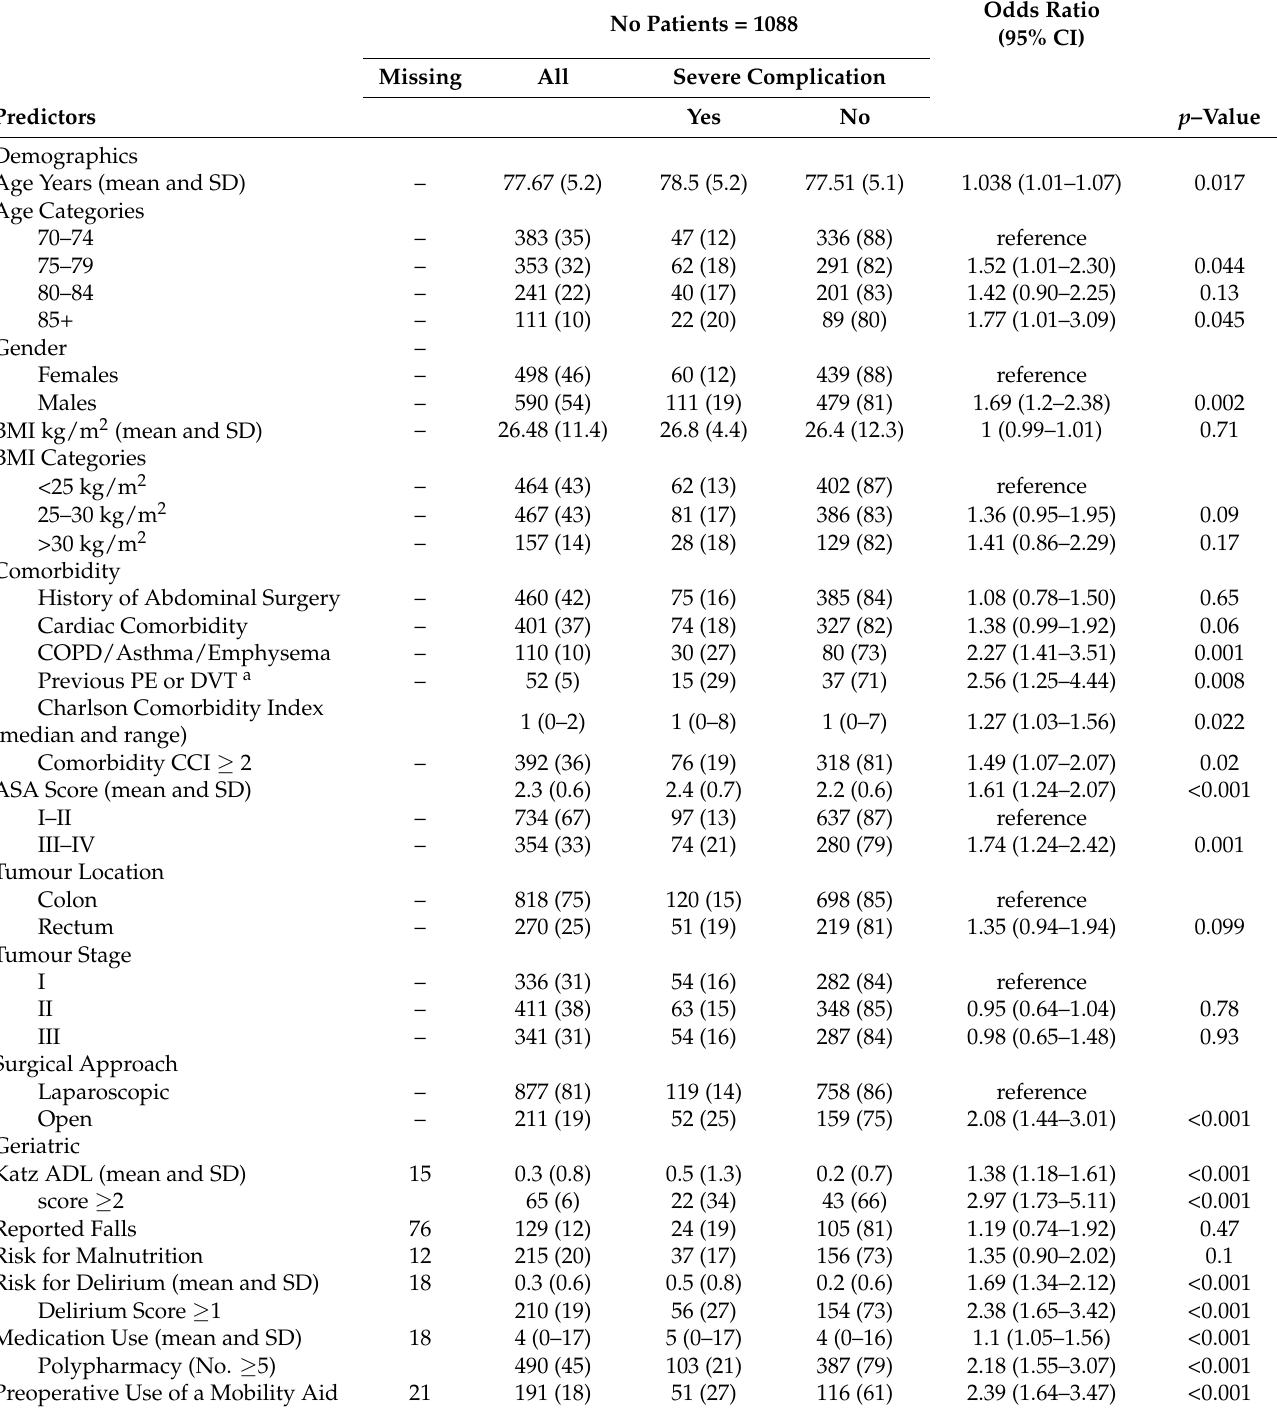
Table 1. Baseline characteristics and univariable associations with severe